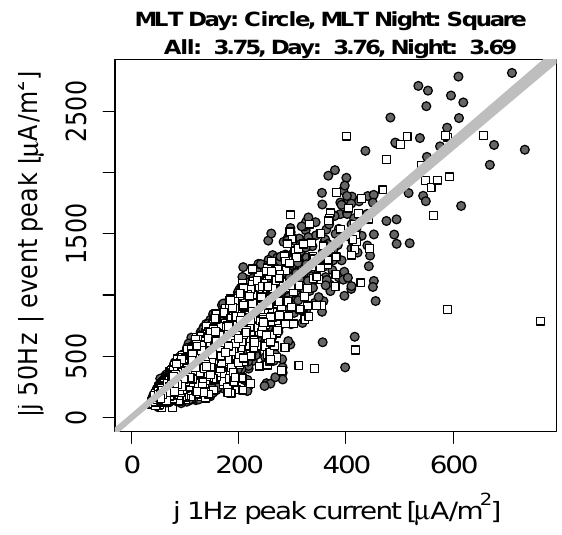
(cid:12) (cid:12) (cid:12) j 50Hz , peak (cid:12) versus j 1Hz , max . The slopes of